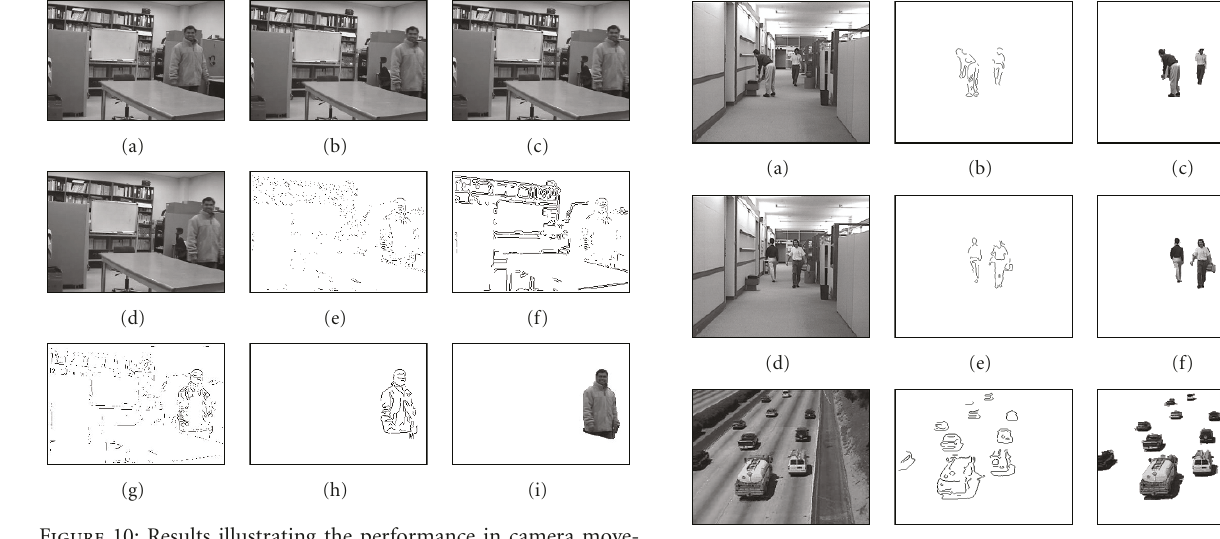
Figure 10: Results illustrating the performance in camera move- ment. (a)–(c) Frames I 255 , I 256 and I 257 with di ff erent camera movement, respectively; (d) frame I 257 having similar movement with frame I 255 ; (e) result obtained by DC using frames in figures (a), (b), and (c); (f) result obtained by DC using frames in figures (a), (b), and (d); (g) result obtained by KW ; (h) result obtained by the proposed method; (i) segmentation result.